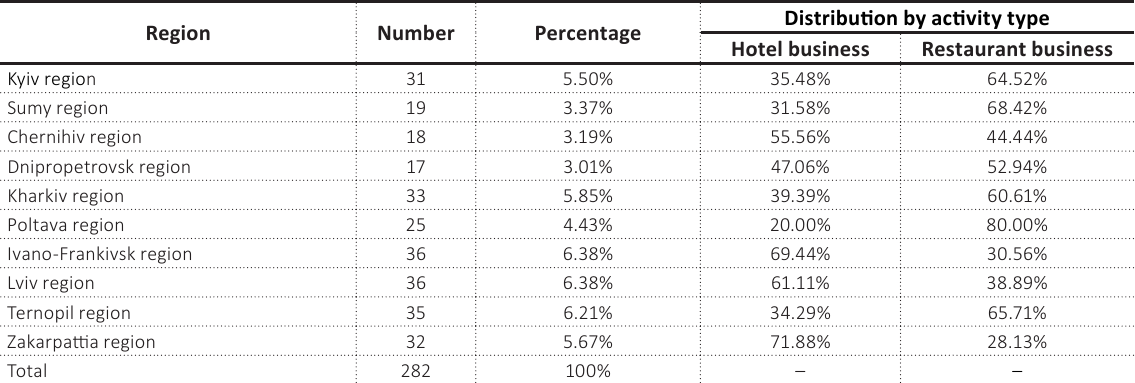
Table 1. Respondents’ profiles by region and industry